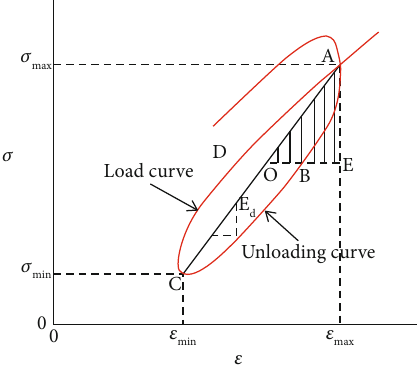
Figure 11: Stress-strain hysteresis